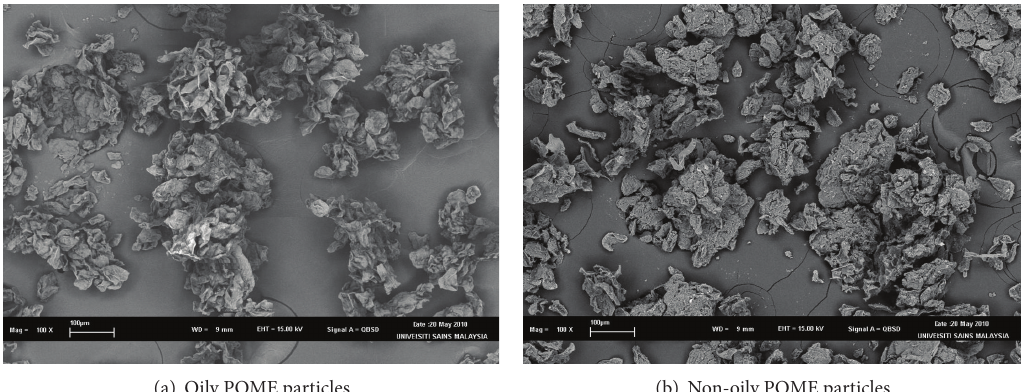
F 3: �EM images of (a) oily and (b) non-oily POME particles at 100� magni�cation.